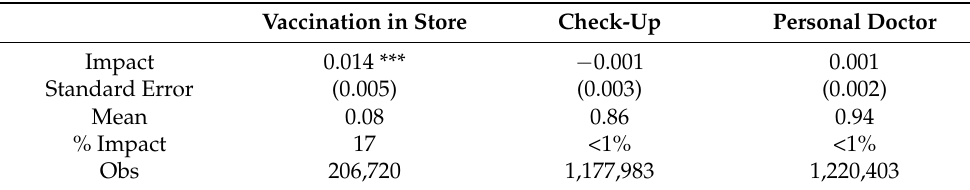
Table 3. Impact of explicit vaccination authority for pharmacists on likelihood of receiving influenza in a store, receiving a check-up or having a personal doctor.